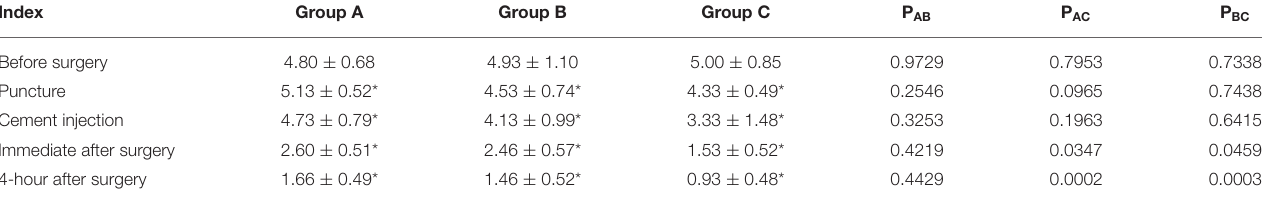
TABLE 2 | The VAS during the different periods.